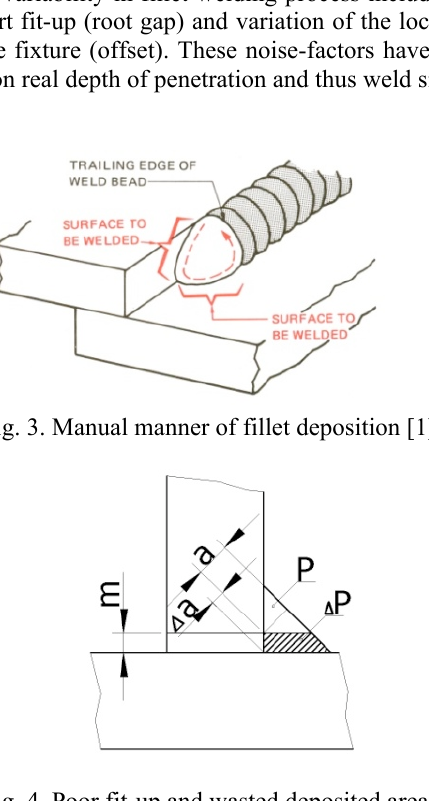
Fig. 4. Poor fit-up and wasted deposited